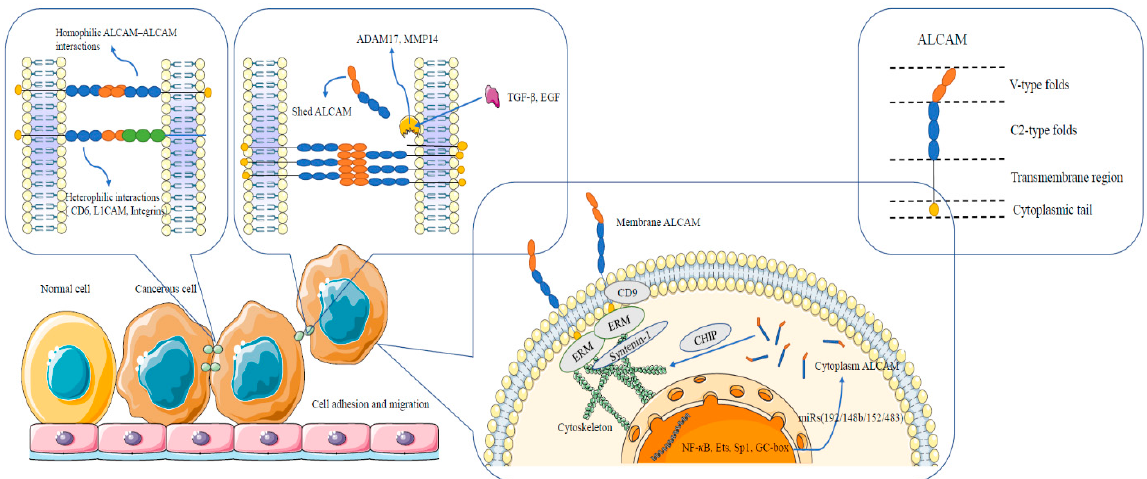
Figure 2. Diagrammatic representation of ALCAM structure and interactions between and within cells. ALCAM, a transmembrane protein, consists of both C2 and V type fold extracellular domains important in its clustering and interactions with neighbouring cells, through either ALCAM-ALCAM or ALCAM-CD6, etc. interactions. Cleavage of ALCAM from the membrane can occur by the proteolytic action of proteases such as ADAM17 or MMP14, releasing or shedding the indicated domains from the cell's surface. ALCAM intracellular interactions have also been indicated.